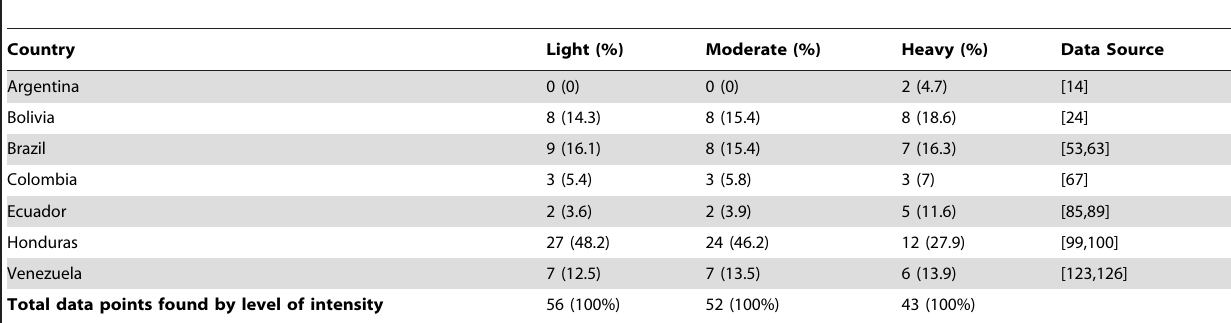
Table 2. Number and relative frequency of data points found for each category of STH intensity of infection by country, 2000–